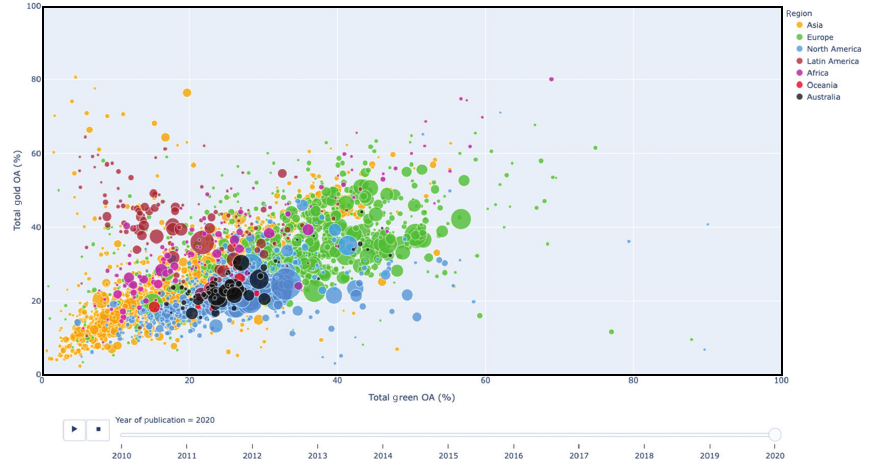
Fig. 3: The Animated version of OA Gold and Green trajectories for the years